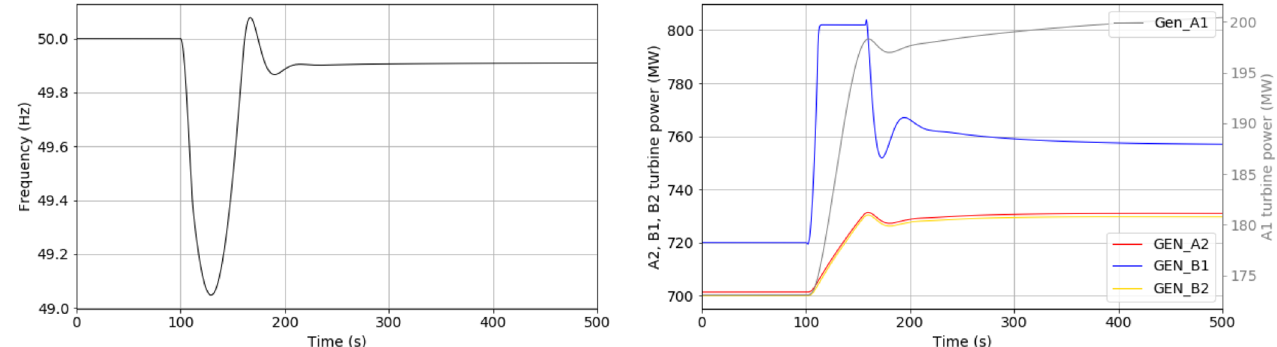
Fig. 10. Frequency transient for 125 MW solar power drop with 3 NPPs and 1 hydraulic power plant.